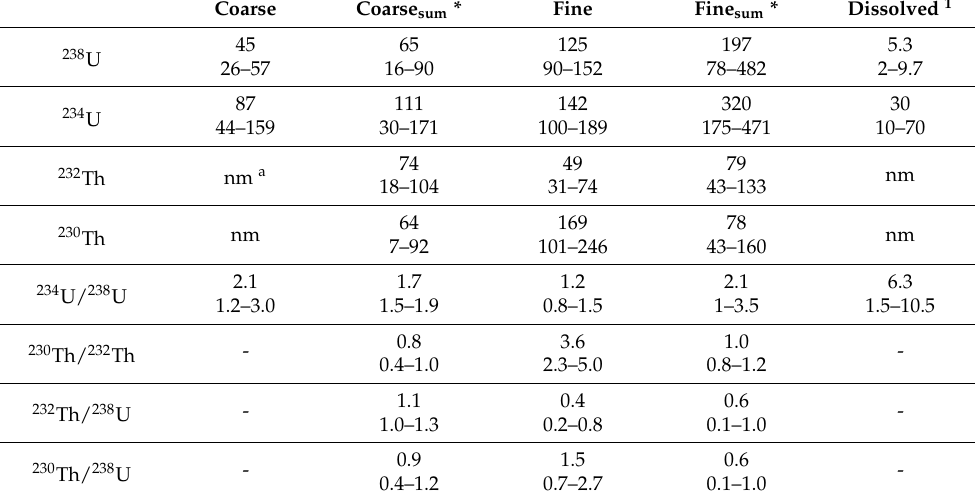
Table 2. Partitioning of 238,234 U and 232,230 Th, mBq kg − 1 , and their activity ratios, in fractions of suspended sediments at high depth.